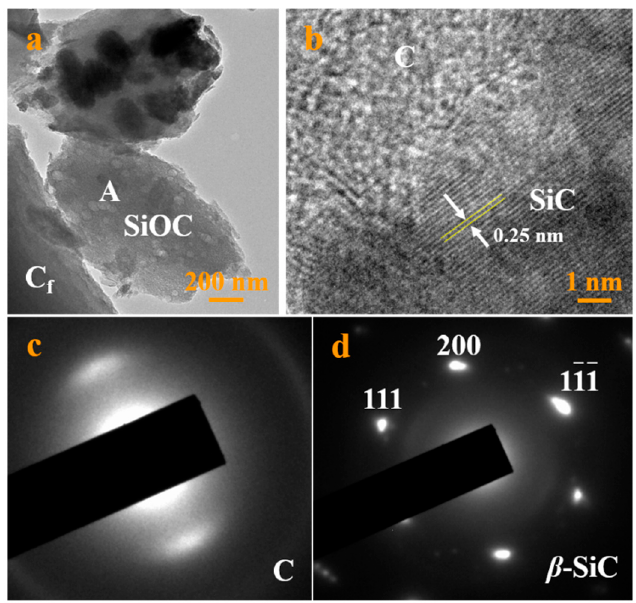
Figure 3. (a) TEM image of as-prepared composites obtained at 1600 ◦ C. (b) HRTEM image of SiOC Figure 3. ( a ) TEM image of as-prepared composites obtained at 1600 °C. ( b ) HRTEM image of SiOC within as-prepared composites obtained at 1600 ◦ C. SAED images of (c) free carbon and (d) SiC within within as-prepared composites obtained at 1600 °C. SAED images of ( c ) free carbon and ( d ) SiC within as-prepared composites obtained at 1600 ◦ C. as-prepared composites obtained at 1600 °C.